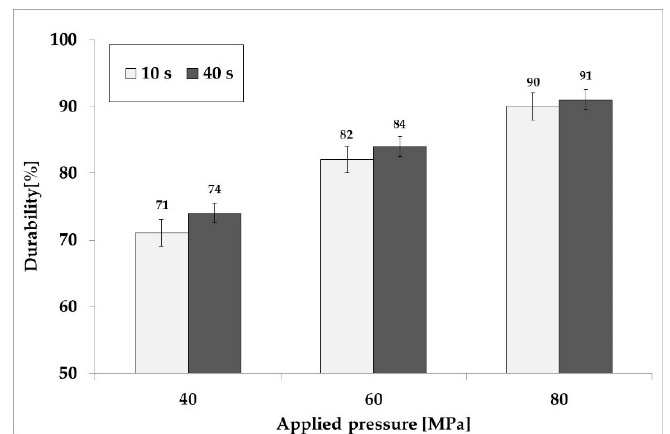
Figure 6. Average compacts durability values (%) obtained by compressing hop cones with three compression pressure levels (40, 60 and 80 MPa) and two pressure application times (10 and 40 s). Error bars indicate standard error ( n = 5).